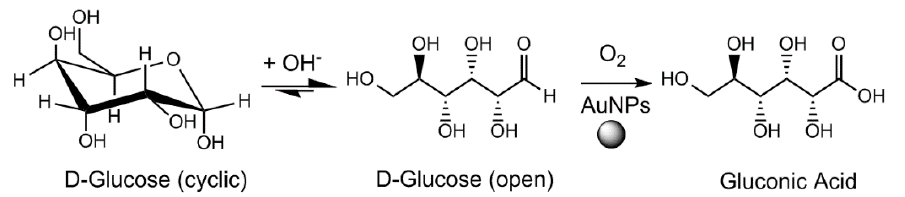
Scheme 1. pH dependent equilibrium and Au-mediated catalytic oxidation of